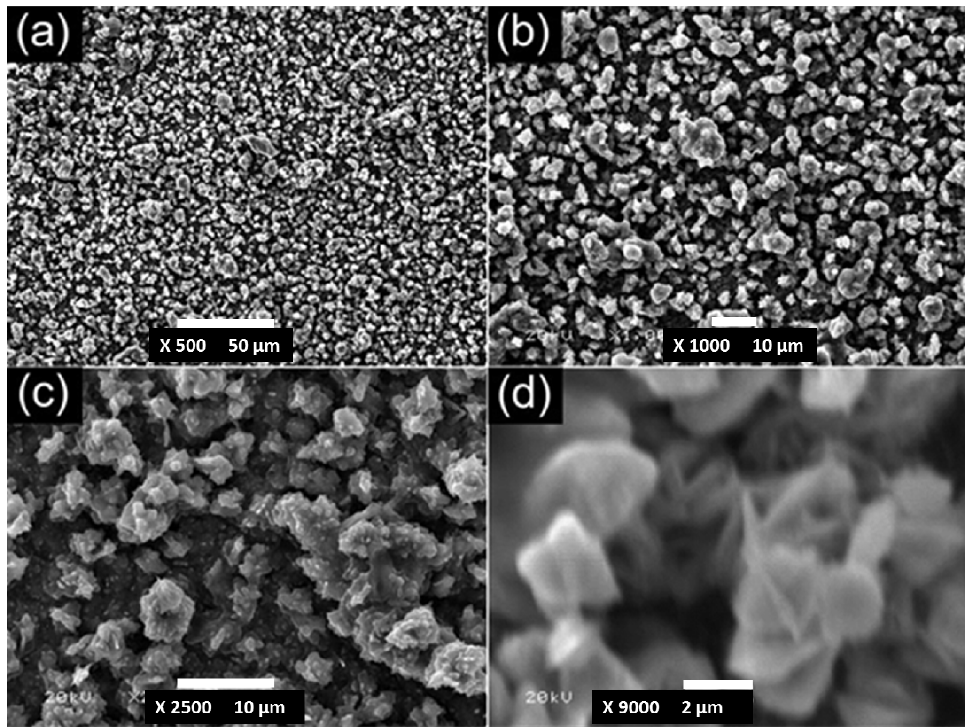
Figure 12. SEM images with various magnifications of the as-prepared copper surface after surface oxidation. Images reprinted from [112], with permission from AIP Publishing LLC, Copyright 2008.